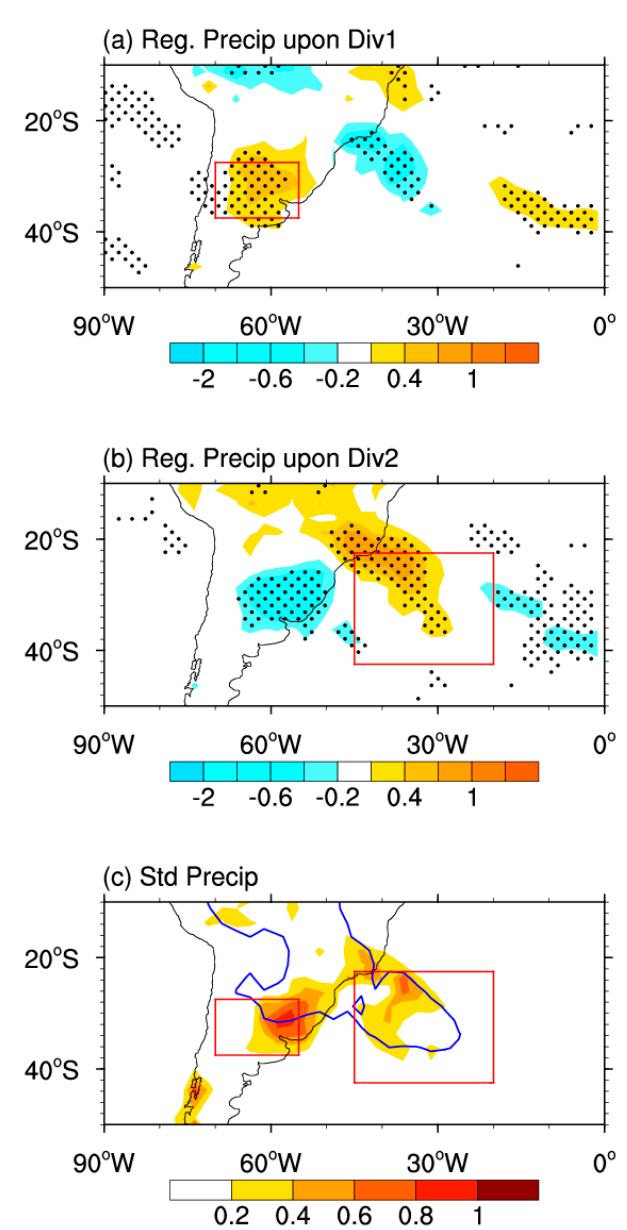
Figure 10. ( a , b ) As in Figure 8b,c, but for anomalies of precipitation. ( c ) Standard deviation of austral summer rainfall (unit: mm d − 1 ), in which the zonal mean is removed. The two boxes depict mid-latitude South America and the southwest South Atlantic. The blue contour represents the climatological rainy belt of the South Atlantic Convergence zone, with mean rainfall averaged over 1980–2016 exceeding 2 mm d − 1 using the CMAP precipitation data.